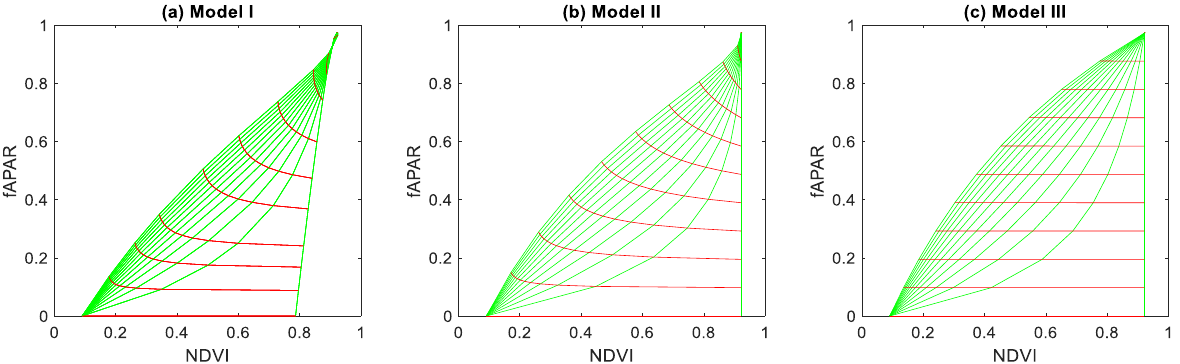
Figure 8. Effects of soil brightness and LAI (model I), C v (model II), and f C (Model III) on the relationships between NDVI (from red and NIR BHRs) and fAPAR shown by red and green lines, respectively, for the three model scenarios. Soil brightness levels R s = 0, 0.05, …, 0.6; LAI levels in panel ( a ) of 0, 0.1, 0.2, 0.35, 0.5, 0.7, 1, 1.5, 2, 4, 8; C v levels in panel ( b ) of 0, 0.1, …, 1; f C levels in panel ( c ) of 0, 0.1, …, 1.